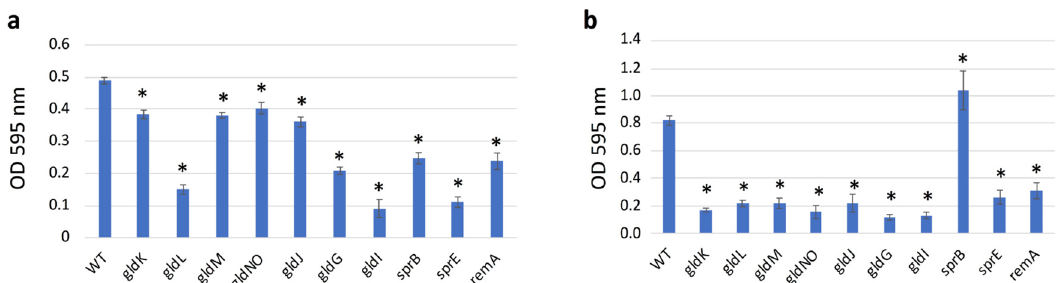
Figure 8. Crystal violet biofilm assay of WT, T9SS mutants ( gldK , gldL , gldM , gldNO , and sprE ), gliding motility proteins mutants ( gldG, gldI , and gldJ ), and adhesin proteins mutants ( sprB and remA ) strains. Cells were cultured in ( a ) PY2 broth or ( b ) CYE broth in a 24-well polystyrene plate for 24 h. The cells formed biofilm on the walls of the wells. Bar chart represents the results of the crystal violet microtiter biofilm assay. Vertical axis: optical density at 595 nm with the standard deviation. All the tested mutants produced biofilm in both nutrient-poor PY2 and nutrient-rich CYE medium. The amounts of biofilm produced by WT and sprB mutants are larger than those by the other mutants in CYE. The plate assay was performed three times for all strains; the averages and standard deviations are indicated. Asterisks denote Student’s t -test significance compared with WT (* p < 0.05).